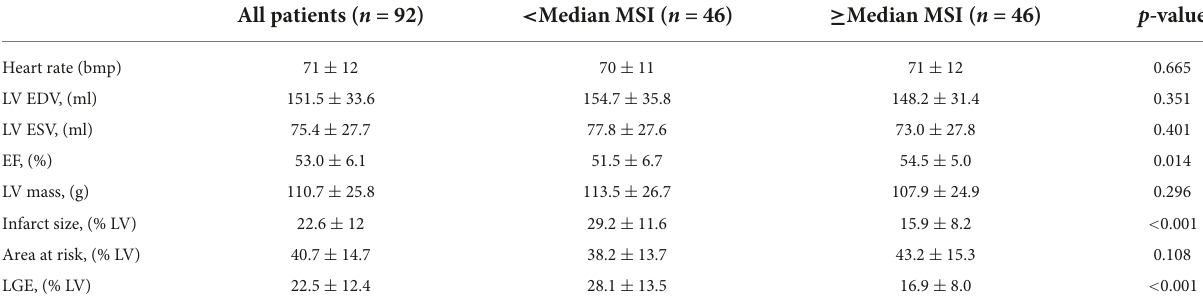
TABLE 2 CMR characteristics of patients with STEMI.